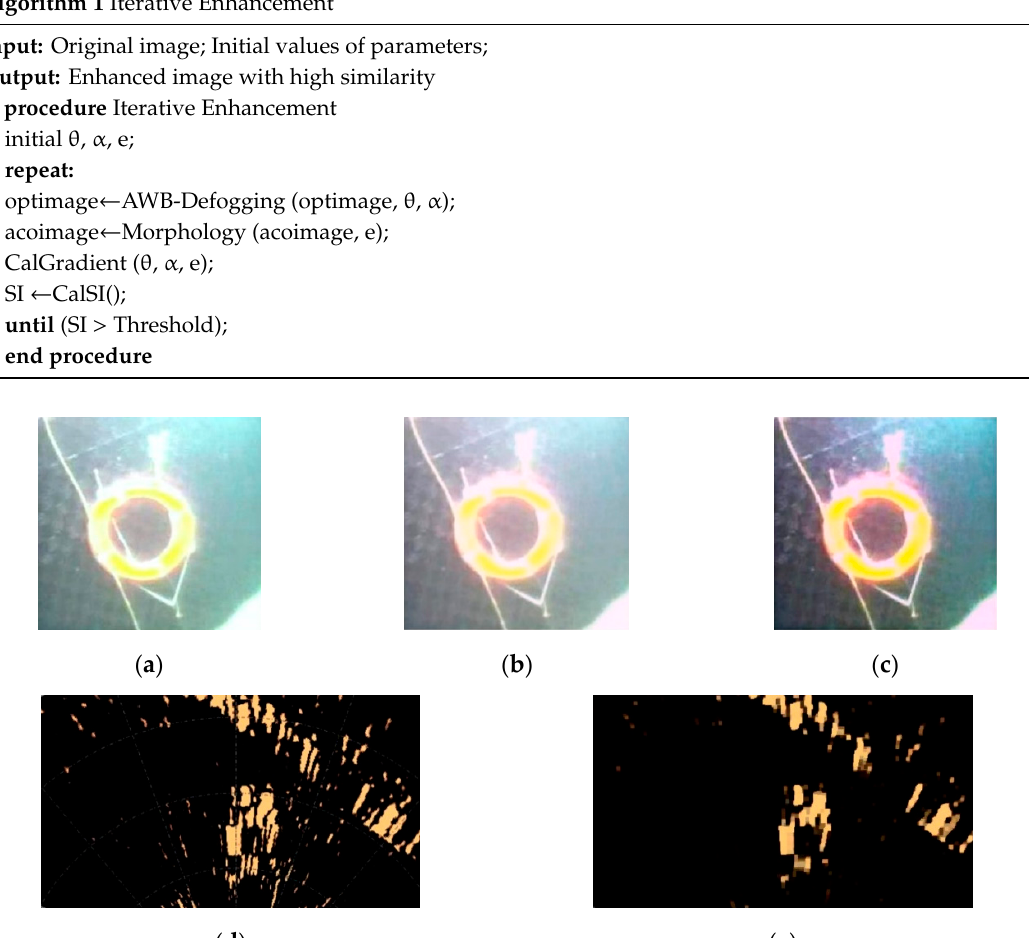
Algorithm 1 Iterative Enhancement